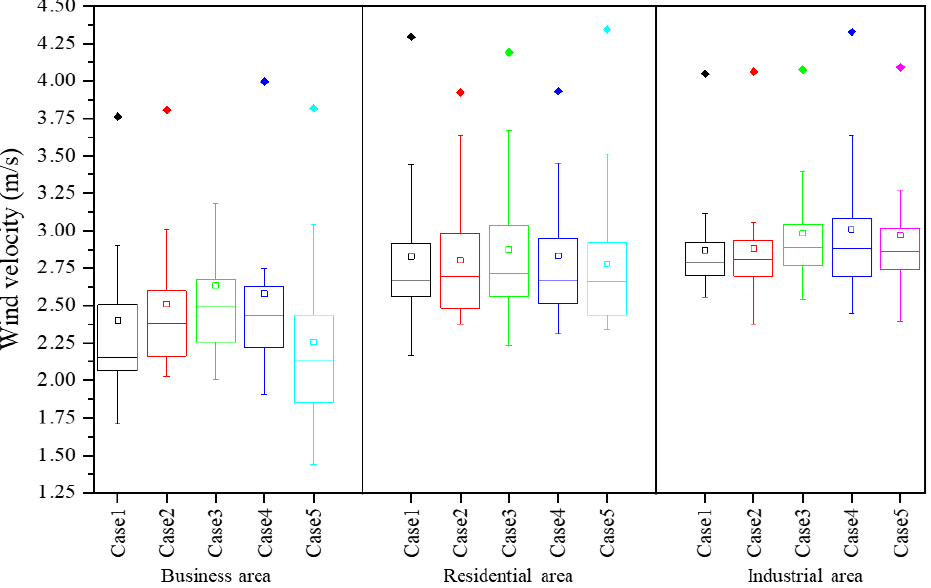
Figure 7. Daily variation in wind velocity of five cases in the business, residential, and industrial areas.